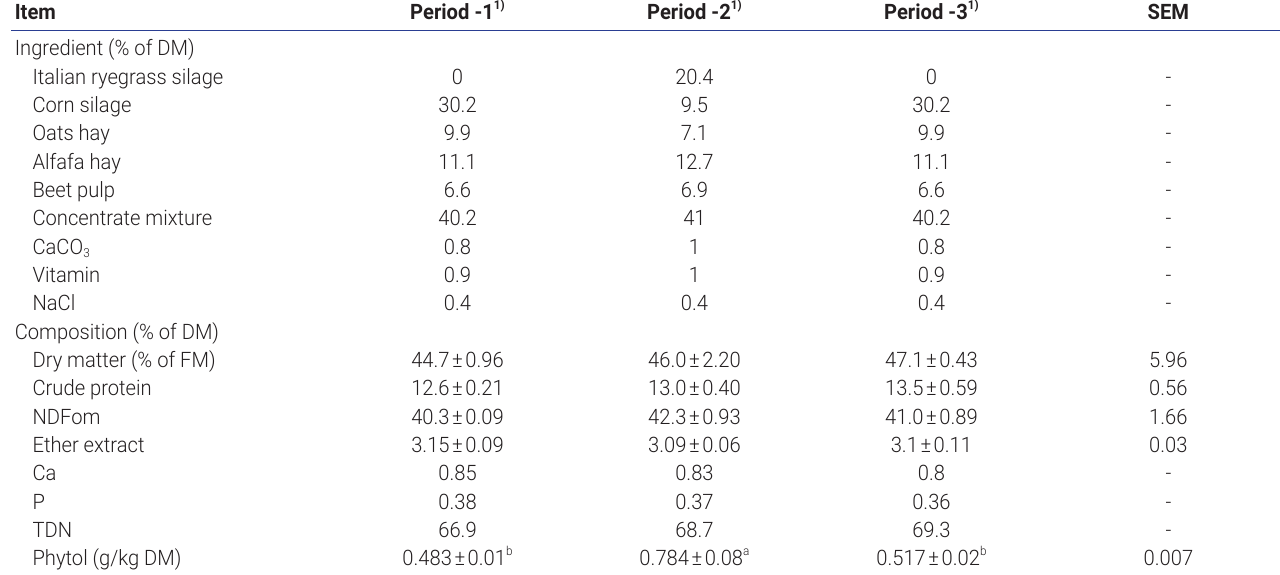
Table 1. Ingredients and composition of total mixed rations for cows at each experimental period